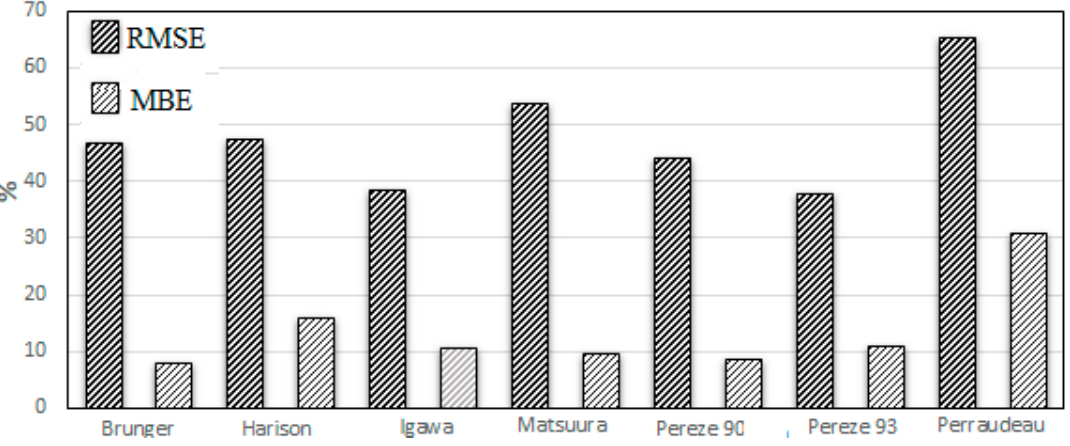
Figure 8. RMSE and MBE for the investigated models (overcast sky).